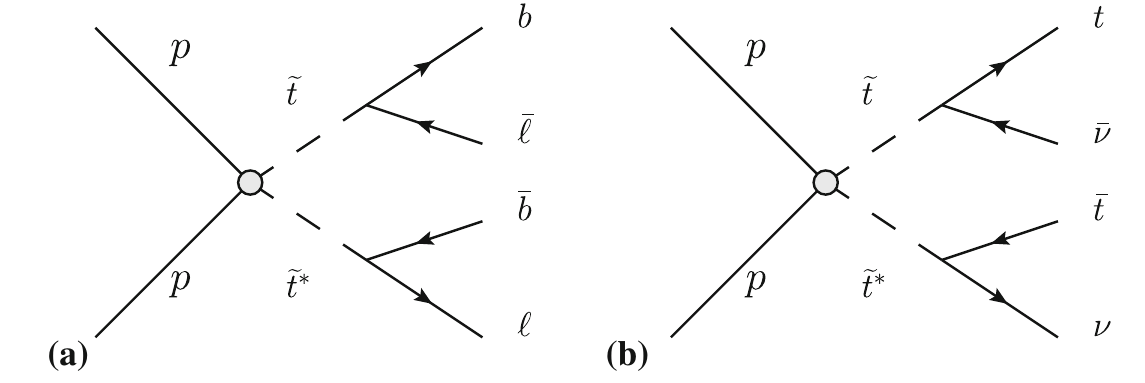
Fig. 3 Processes relevant for the detection of the stop as the LSP at the